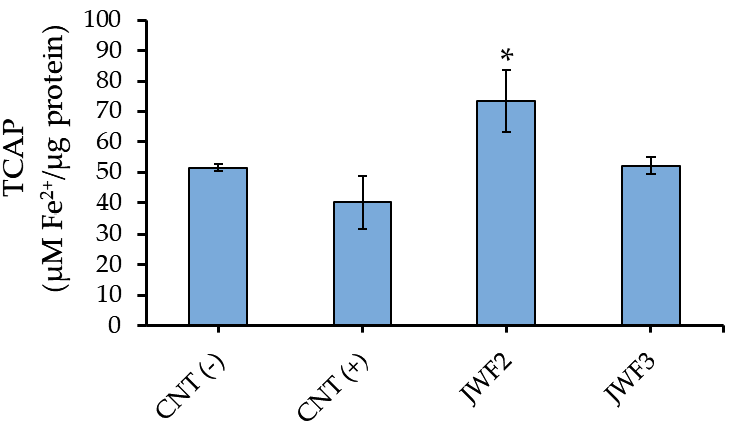
Figure 3. Effect of JWE and fractions (JWF2 and JWF3) on the total cellular antioxidant power of RBC. RBC were treated with maximal protective concentrations of JWF2 (7.8 µg.mL −1 ) and JWF3 (31 µg.mL −1 ) and challenged with 7 mM AAPH (OC 50 ) for 4 h. Each point represents the mean of two independent experiments ± standard error. The asterisk (*) indicates a significant difference between JWF2 and CN T (+) (ANOVA and Dunn’s test, p < 0.05). CNT (-), negative control (untreated RBC); CNT (+), positive control (RBC treated with 7 mM AAPH).